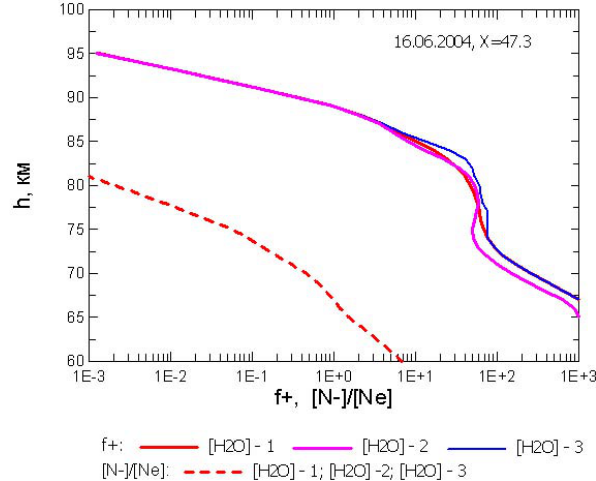
and Cl + positive ions 1 2 Fig. 6a. Profiles for f + (solid lines) and λ = N − /N e (dashed line) for 16 June 2004 at 12:00UT, with a solar zenith angle of 47.3 ◦ and calculated for H 2 O-1, H 2 O-2 and H 2 O-3 profiles.